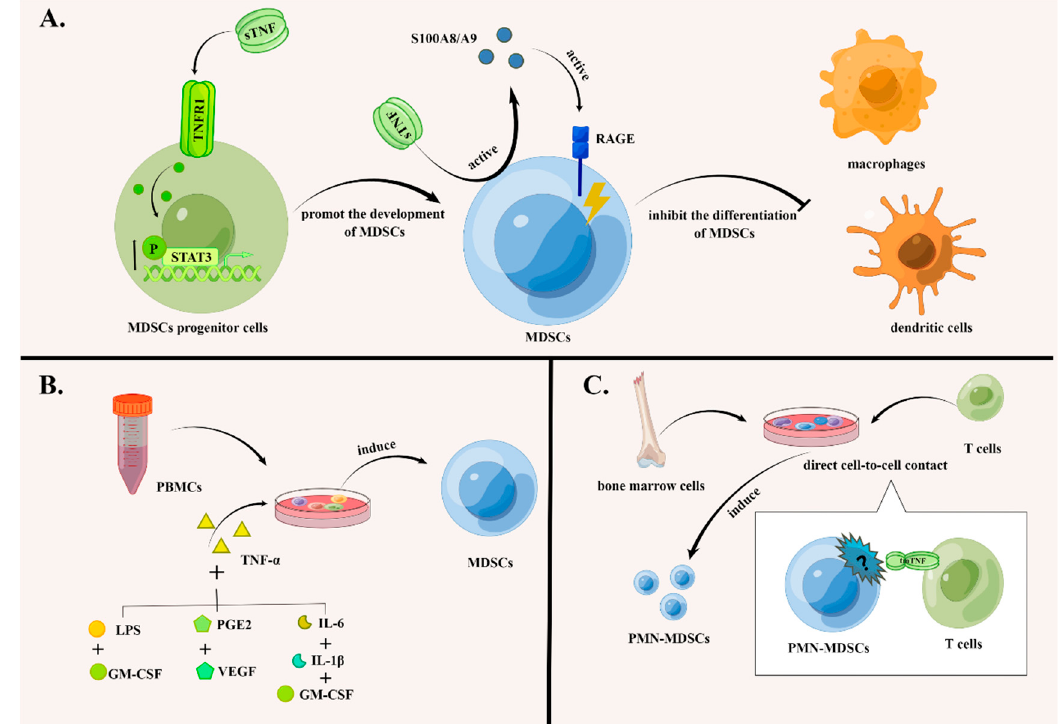
Figure 1. TNF signaling promotes the accumulation of MDSCs in multiple ways. ( A ) TNF signaling promotes the development of MDSCs and suppresses their differentiation. sTNF- α enhances the phosphorylation of transcription factors of Stat3 in MDSCs progenitor cells, which facilitates the development of MDSCs. In addition, TNF- α inhibits the differentiation of MDSCs into dendritic cells and macrophages mediated by the inflammatory proteins S100A8/A9 and their corresponding receptors, such as RAGE, promoting the accumulation of MDSCs. ( B ) MDSCs can be induced from PBMCs with the participation of TNF- α . The combined administration of TNF- α , GM-CSF and LPS; the administration of TNF- α , PEG2 and VEGF; and the administration of TNF- α , IL-6, IL-1 β and GM-CSF can induce MDSCs with immunosuppressive functions from PBMCs. ( C ) PMN-MDSCs